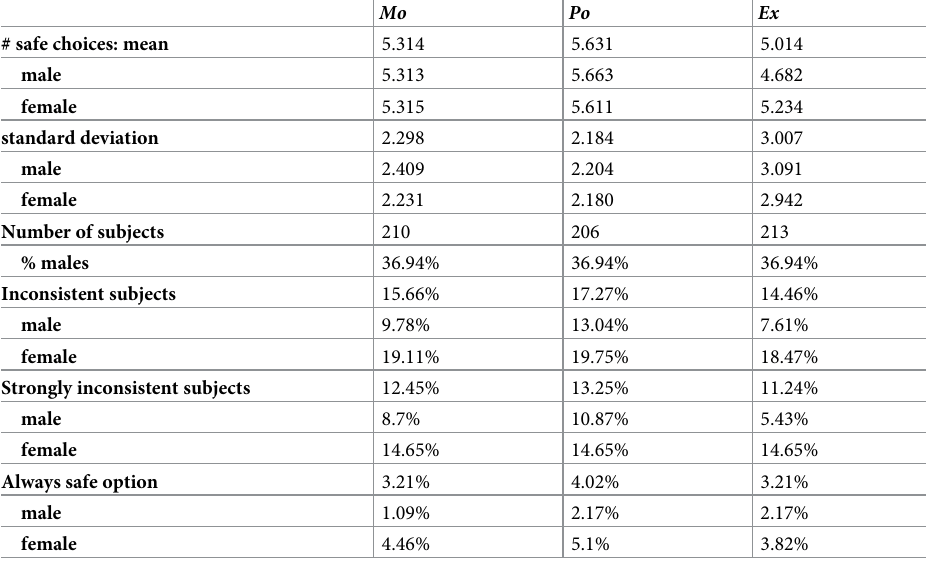
Table 6. Descriptive statistics for each